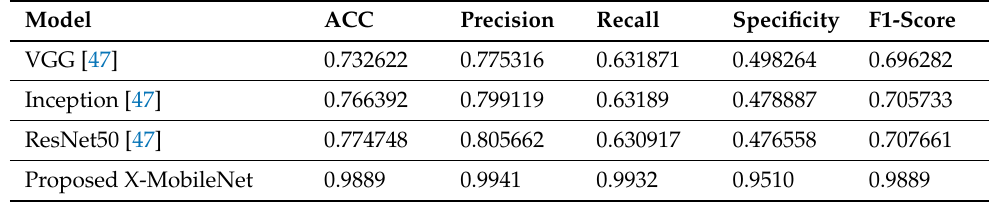
Table 5. Performance comparison with other ImageNet